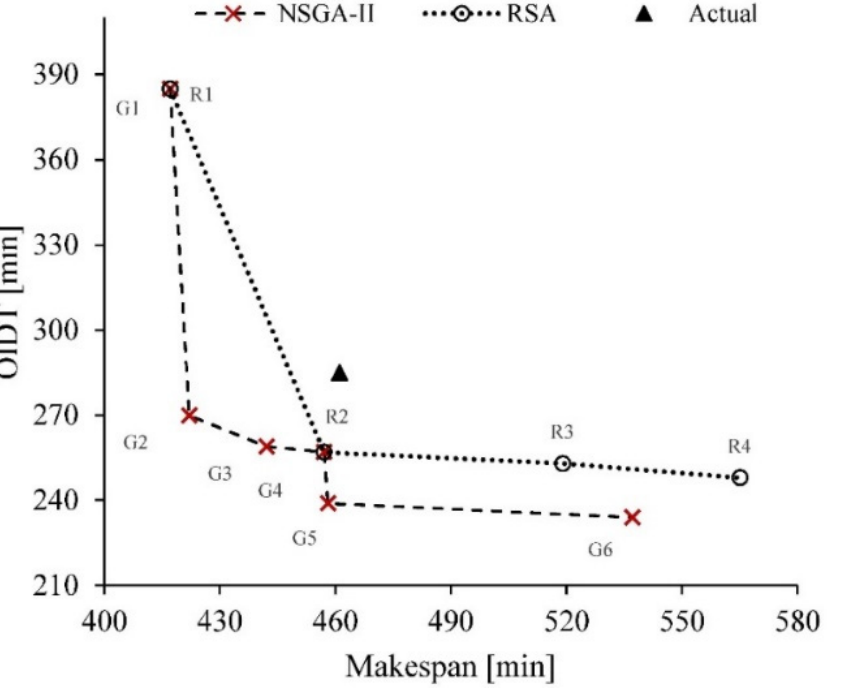
Figure 17. The solutions obtained by NSGA-II and RSA for BMP-VI.